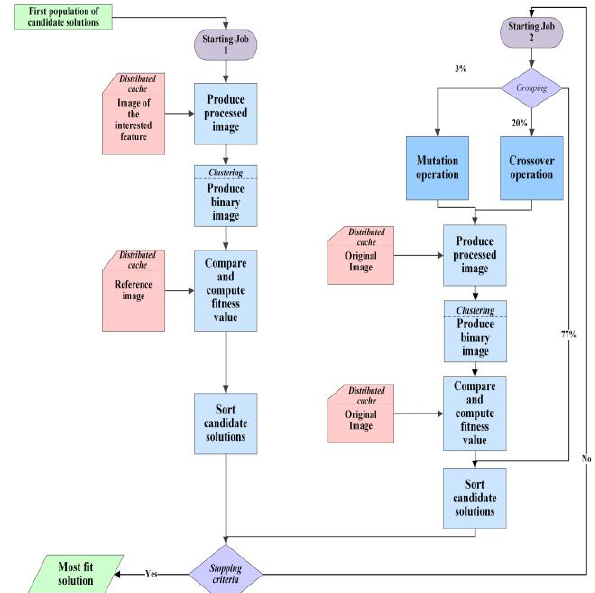
Figure 6. Diagram of the proposed system.